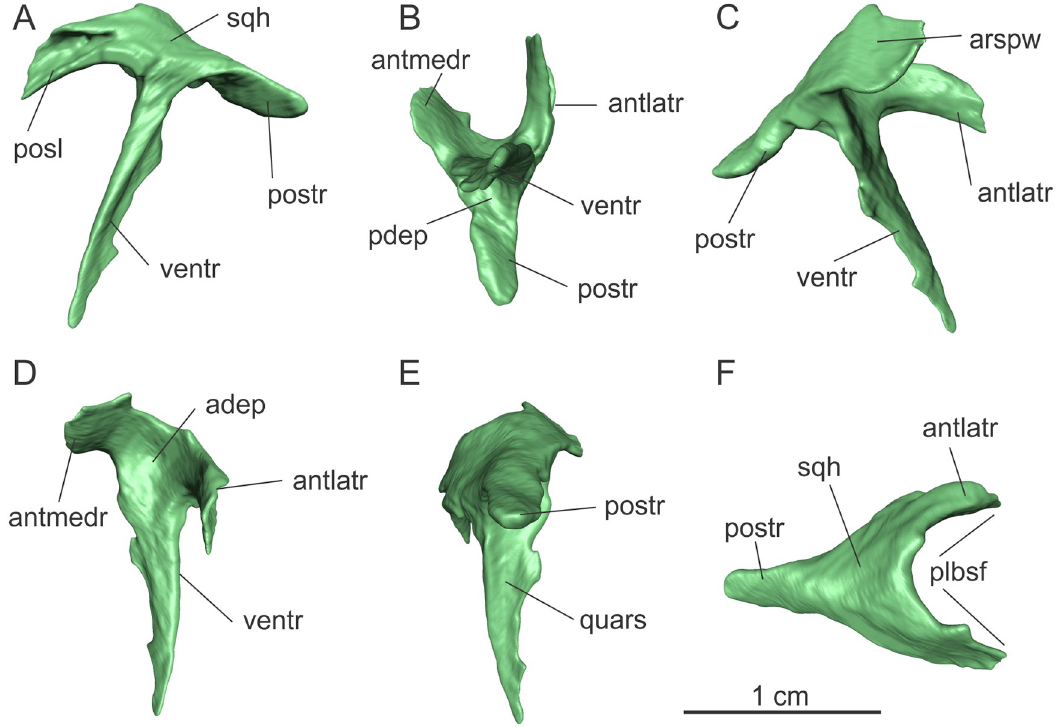
Fig 7. Left squamosal of the specimen MCP-3845-PV of Saturnalia tupiniquim in lateral (A), ventral (B), medial (C), anterior (D), posterior (E), and dorsal (F) views. Abbreviations: adep— anterior depression; antlatr— anterolateral ramus; antmedr— anteromedial ramus; arspw— articulation surface with the parietal wing; pdep— posterior depression; plbsf— posterolateral border of the supratemporal fenestra; posl— articulation slot with the postorbital; postr— posterior ramus; quars— articulation surface with the quadrate; sqh— head of the squamosal; ventr— ventral